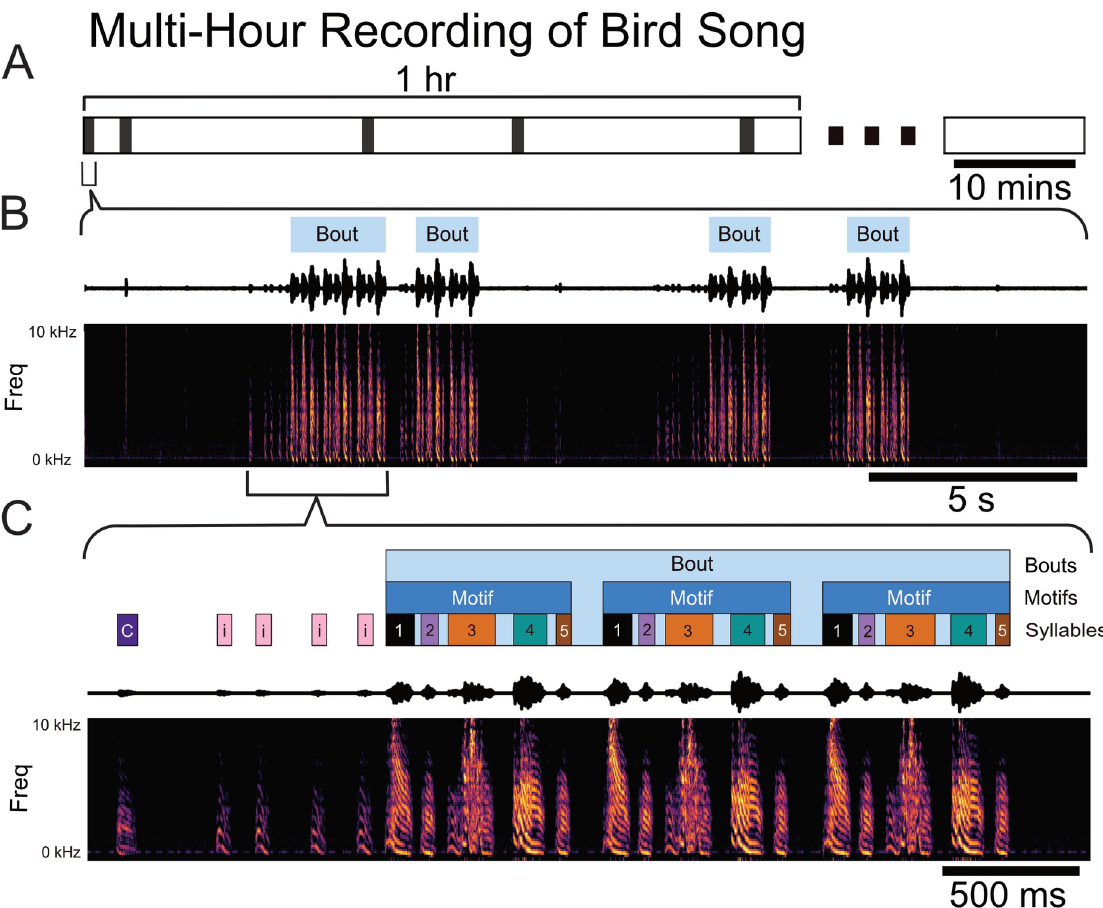
Fig 2. Temporal structure of vocal behavior. (A) Schematic showing the intermittent occurrence of vocally active periods (VAPs, black bar) at sporadic intervals throughout the first hour of a multiple-hours-long continuous recording session of one male zebra finch (z007). (B) Zoomed-in view of one 25-second-long VAP comprising several bouts, denoted by light-blue rectangles above the sound pressure waveform and corresponding spectrogram. (C) Zoomed-in view of the first bout in segment (B) showing introductory notes, typically repeated a variable number of times prior to the start of the bout and labeled as “’; other vocalizations not part of the courtship song, labeled ‘C’; and syllables comprising the courtship song, labeled ‘1’, ‘2’, ‘3’, ‘4’, and ‘5’, based on their sequential order in the motif.